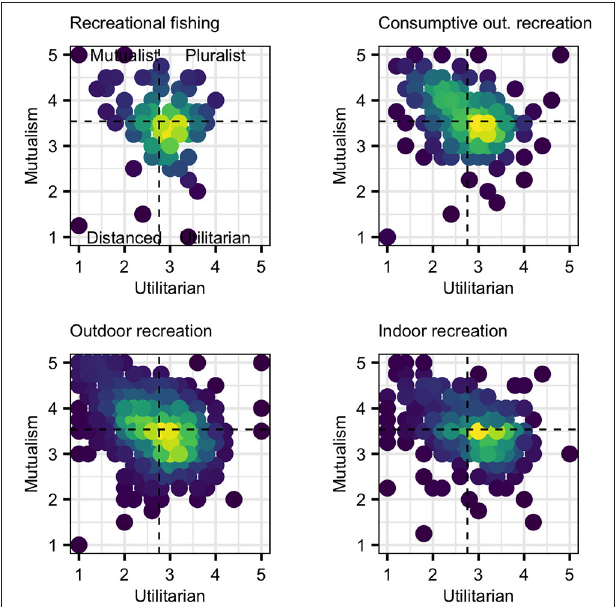
FIGURE 5 | Segmentation of the respondents (dots) into four different types of wildlife-related value orientation (WVO) types by comparing the scores (level of agreement with belief items on a scale from strongly disagree to strongly agree) on domination and mutualism via a cross-tabulation across the four OR and IR activities. The colors represent the density of points. The proportions plot shows the proportion of the WVO types (mutualists, M; utilitarians, U; pluralists, P; and distanced, D) in the different profiles. No significant differences were found among the four IR and OR profiles.